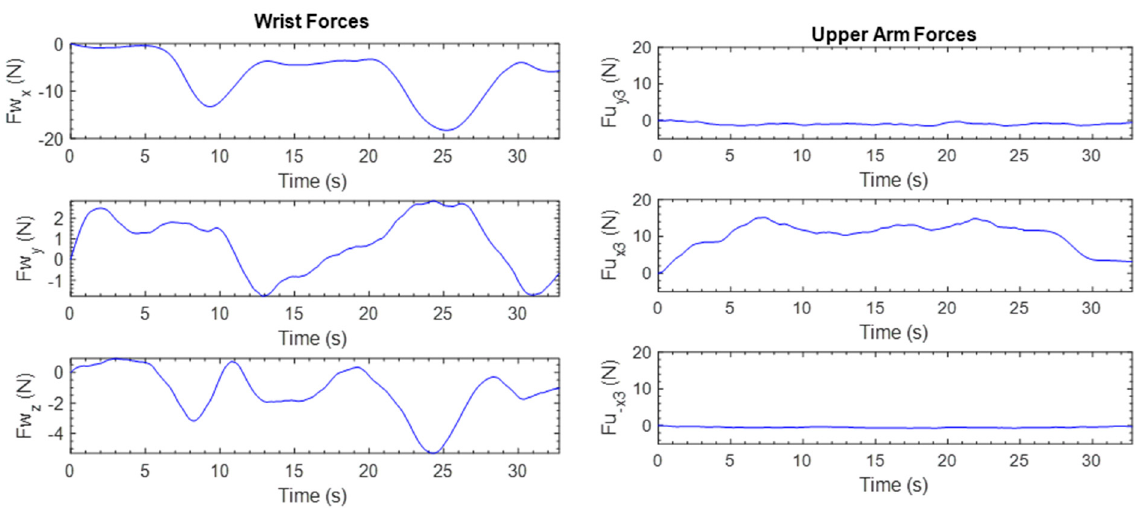
Figure 21. Subject’s forces during shoulder vertical flexion–extension.